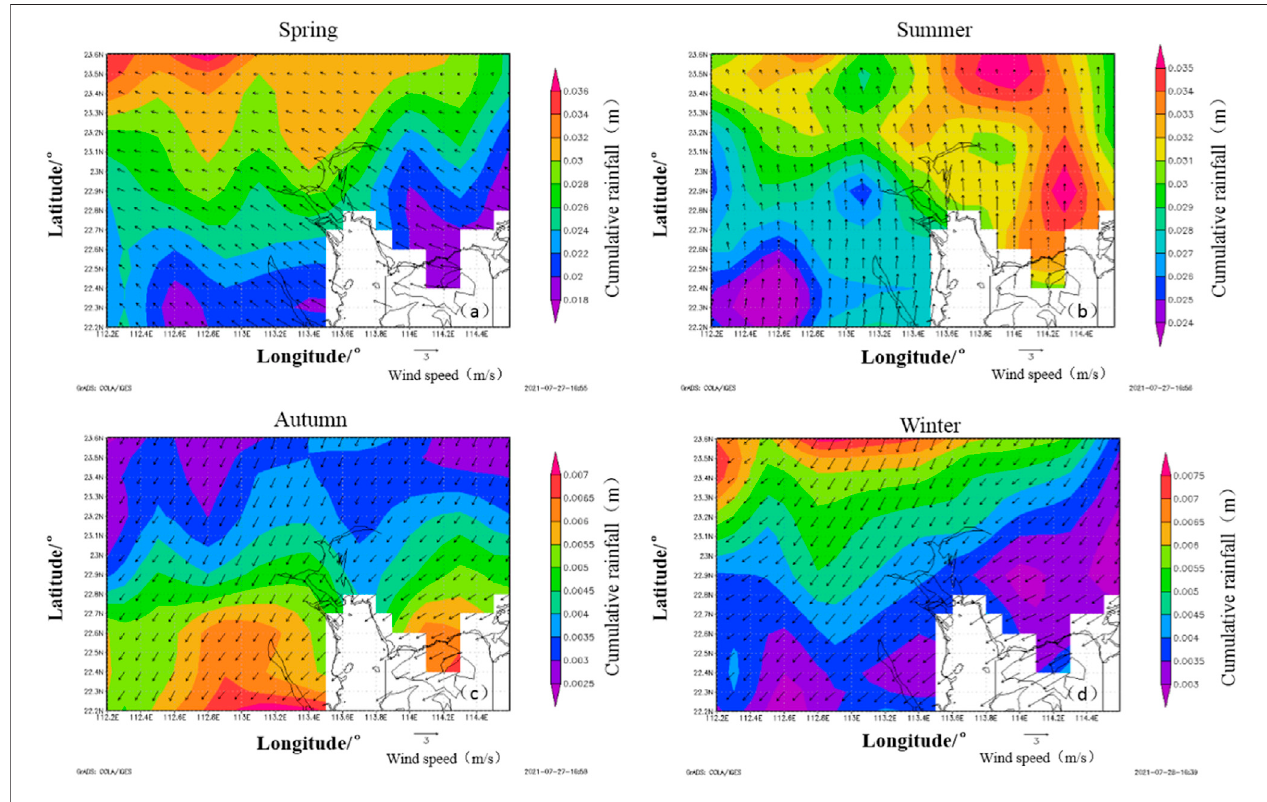
FIGURE 4 | 10 m wind fi eld and accumulated rainfall in the PRD.